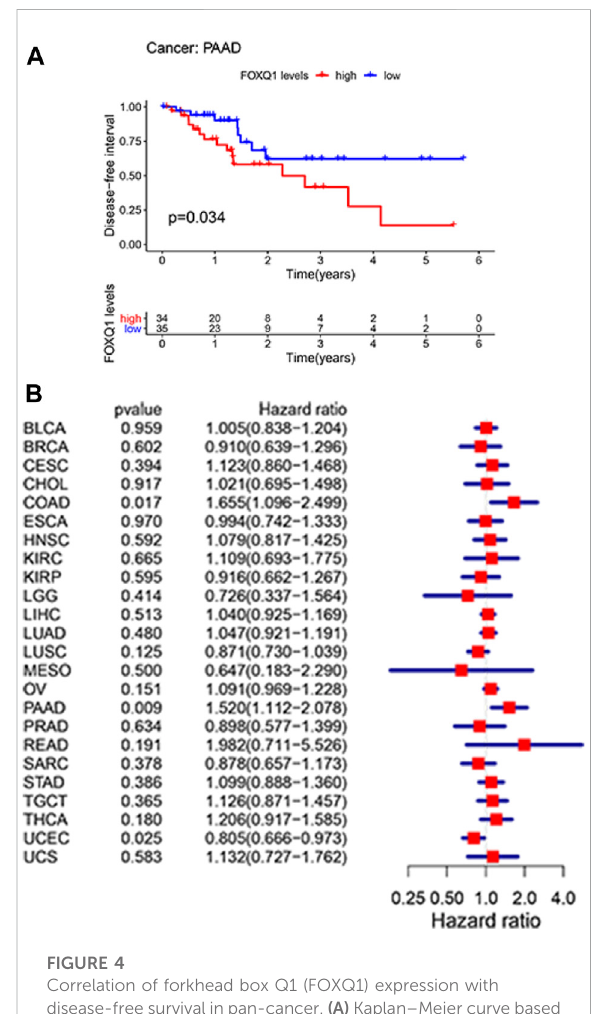
FIGURE 4 Correlation of forkhead box Q1 (FOXQ1) expression with disease-free survival in pan-cancer. (A) Kaplan – Meier curve based FOXQ1 expression in cancer. The red color represents high expression, and the blue color represents low expression. (B) forest plot for the disease-free survival of FOXQ1 in